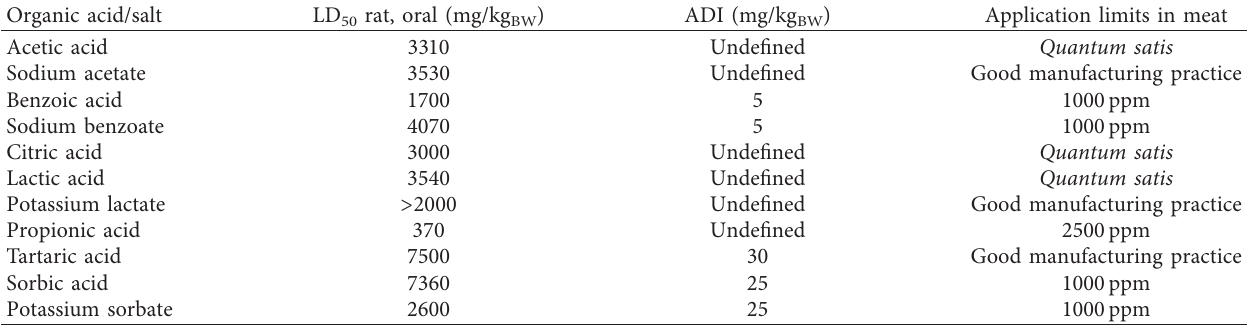
Table 4: Lethal dose by rat oral ingestion (LD 50 rat), Acceptable Daily Intake (ADI), and application limits in meat of commonly used organic